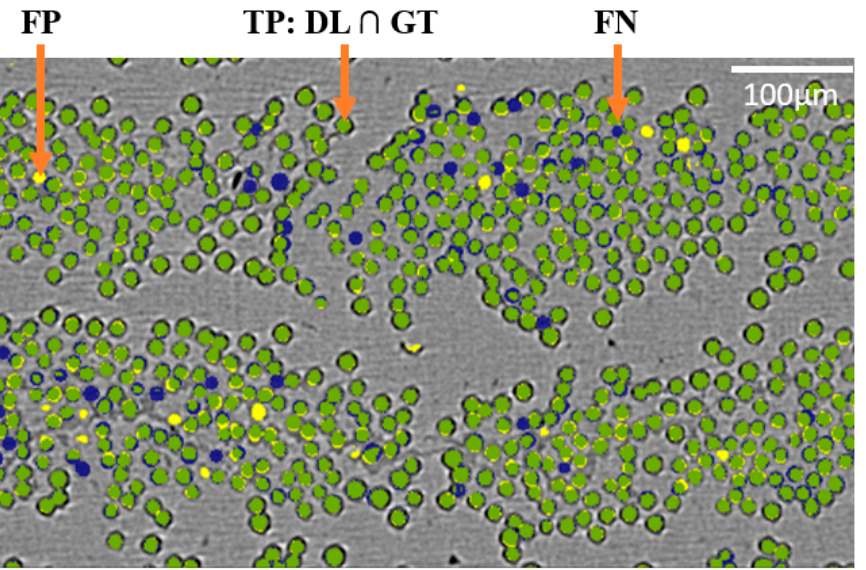
Figure 6. Superposition of CT image with two segmentations: (i) ground-truth segmentation (GT) obtained by manual segmentation of the CT image and (ii) deep learning segmentation (DL). Green = intersection of DL and GT; yellow = fibers identified by DL but not in GT (FP); blue = fibers in GT but missed by DL (FN).